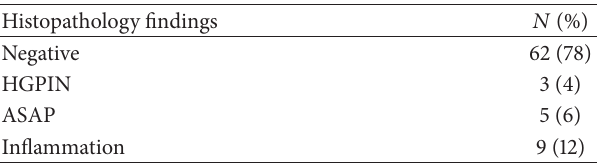
Table 1: Nonmalignant histopathology results of prostate biopsies at the Jamaica Cancer Society (1995–2005).